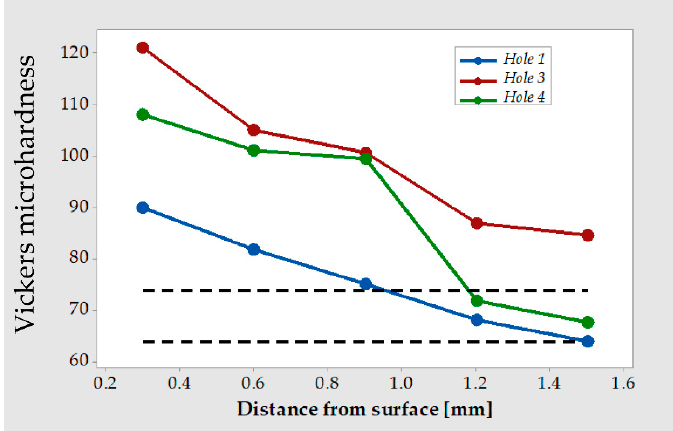
Figure 12. Vickers microhardness measurements from the machined surface of the sectioned holes.